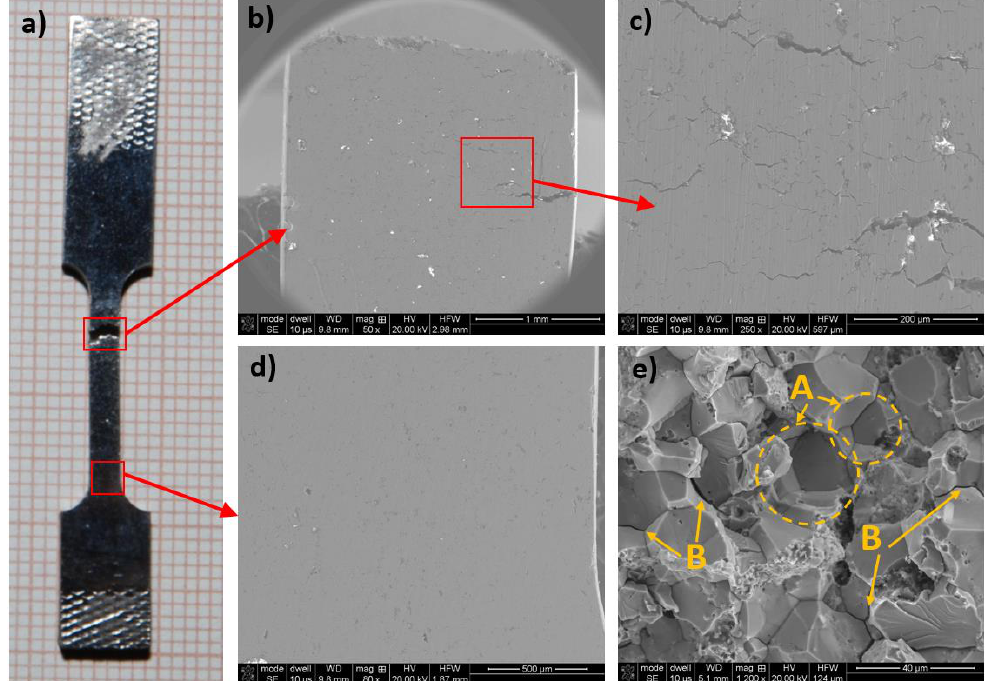
Figure 9. Macrostructure of the entire specimen after tension test ( a ), just below the fracture place ( b , c ), the area near the end of the narrowed sample area ( d ), ( e )-the fracture view.